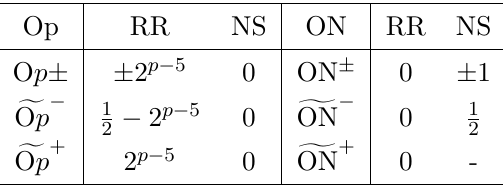
Table 7. The RR and NS charges of the various O-planes.